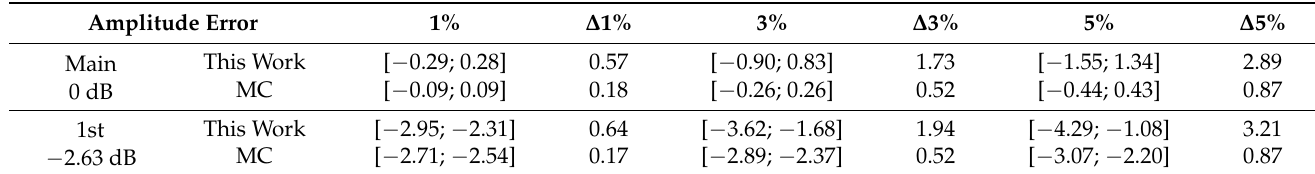
Table 5. Numerical results of SLL of power pattern in Figures 19 and 20.